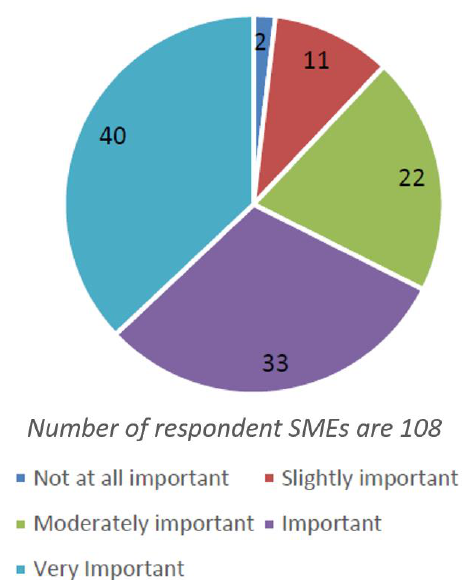
Figure 3. How important is clean, sustainable or green production for your company?